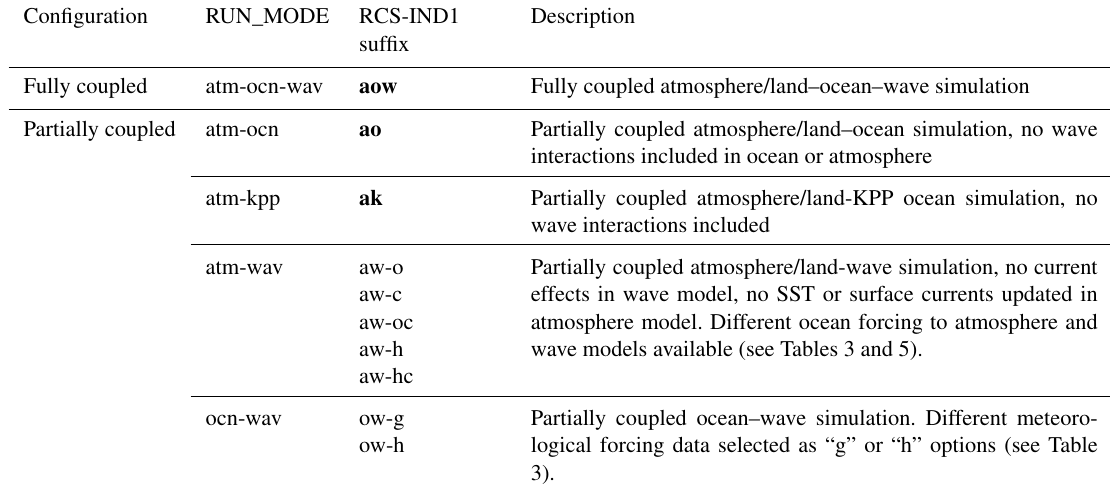
Table 1. Summary of the RCS-IND1 fully and partially coupled configurations available within the RCS, and naming conventions used in this paper. Options are controlled in the RCS using the RUN_MODE environment variable. Results for configuration names in bold are demonstrated in this paper. See also Fig. 2.